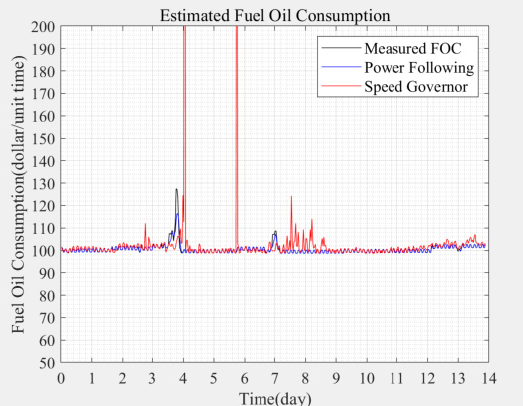
Figure 1. Fuel oil consumption time series due to different speed control methods.